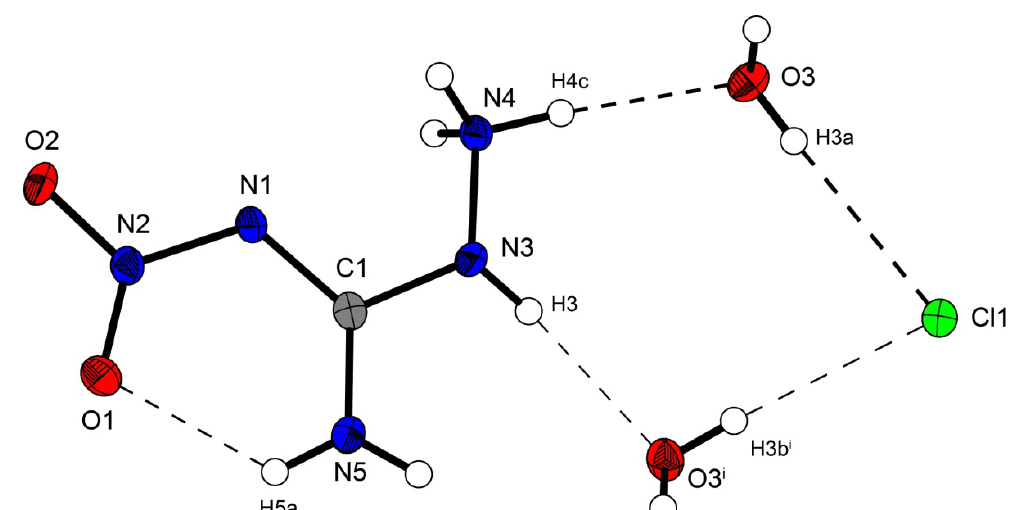
Figure 2. Molecular structure of amino-nitro-guanidinium chloride monohydrate ( 2 ). Ellipsoids are drawn at the 50% probability level. Symmetry code: (i) 0.5 + x , 0.5 − y , 0.5 + z